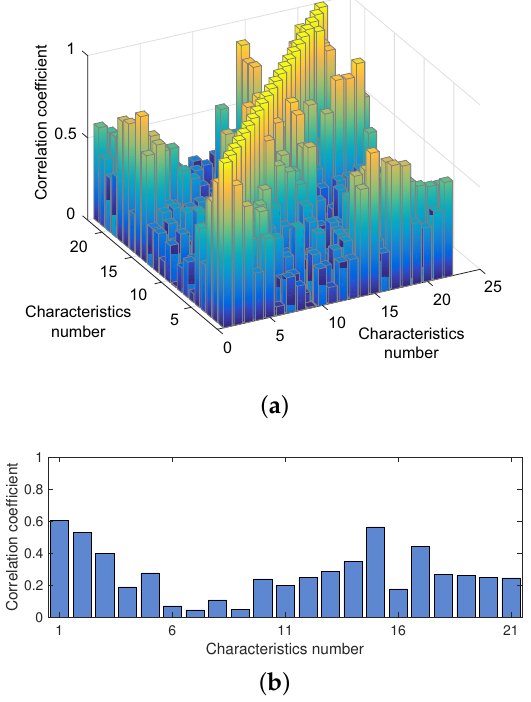
Figure 4. Correlation coefficient between characteristics of driving cycles: ( a ) correlation coefficient between each characteristic. ( b ) Correlation coefficient between characteristics and fuel consumption.